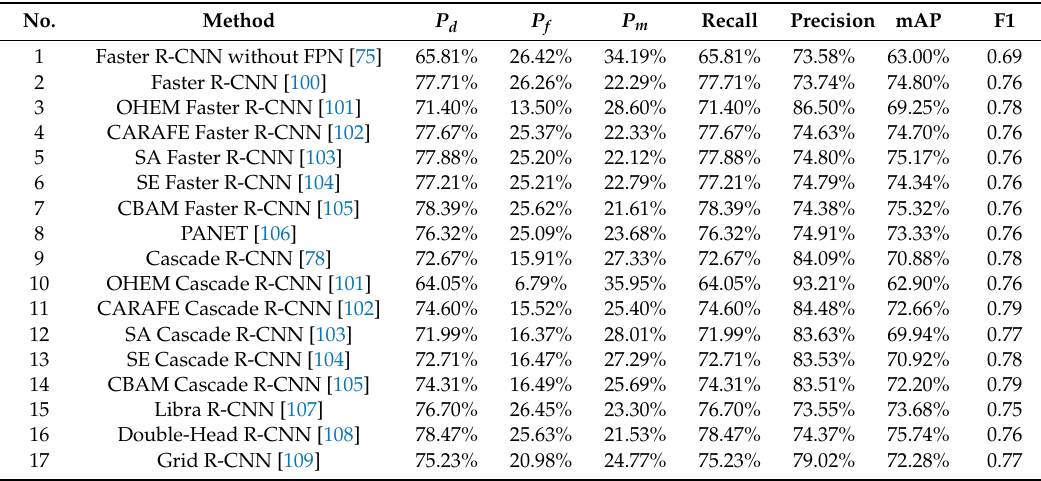
Table 9. Research baselines of the entire scenes. P d : Detection probability; P f : False alarm probability; P m : Missed detection probability; mAP: mean Average